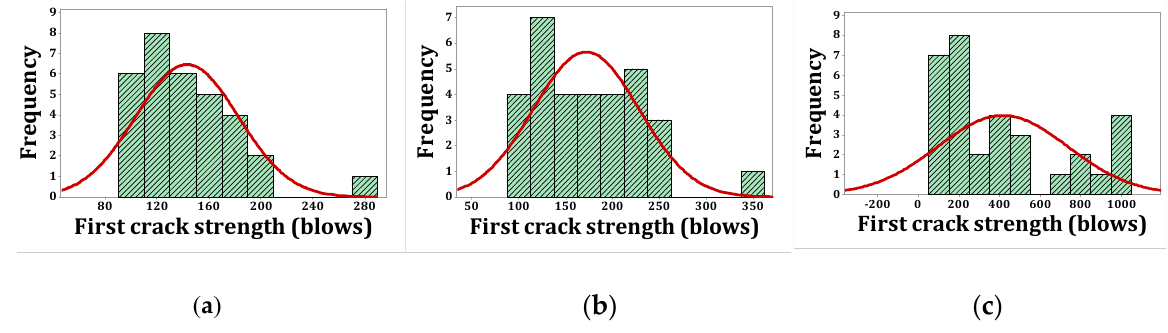
Figure 12. Distribution plots for first crack (humid): ( a ) R, ( b ) F2, ( c ) F3.